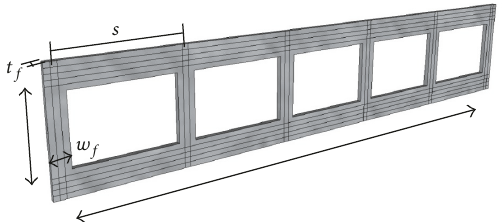
Figure 1: Shape of a GFRP plate.